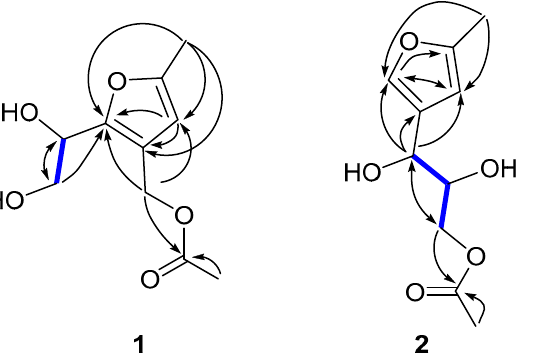
Figure 3. Key COSY (bold lines) and HMBC (arrows) correlations of compounds 1 – 2 . The absolute configuration of 1 was determined by computational methods. Firstly, conformational analyses of 1 were carried out via Spartan 10 software using molecular mechanisms with an MMFF force field with a Boltzmann population of over 5%. Subse- quently, the selected conformers of 1 were reoptimized at the B3LYP/6-31 + g (d, p) level in methanol by the Gaussian 09 program. The ECD spectra were simulated by the overlapping Gaussian function ( δ = 0.35 eV), in which velocity rotatory strengths of the first 60 exited states were calculated. In order to obtain the final ECD spectra, the simulated spectra of the lowest energy conformers were averaged according to the Boltzmann distribution theory and their relative Gibbs free energy ( ∆ G). The results showed that the calculated CD curves of (6 R )- 1 showed good agreement with the experimental ones (Figure 4). Thus, the absolute structure of 1 was determined as shown and named Nicardifuran D.